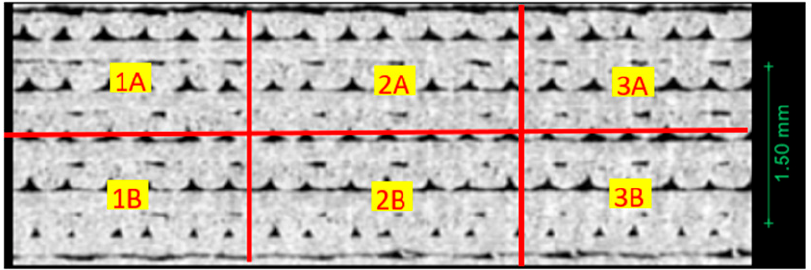
Figure 2. Illustration of segmented volume areas used in micro-CT porosity determination of AM- fabricated CFRP composites.